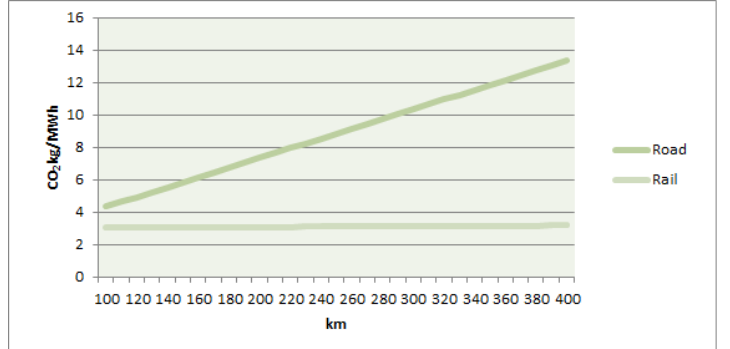
Figure 4. Emissions for the biofuel system.